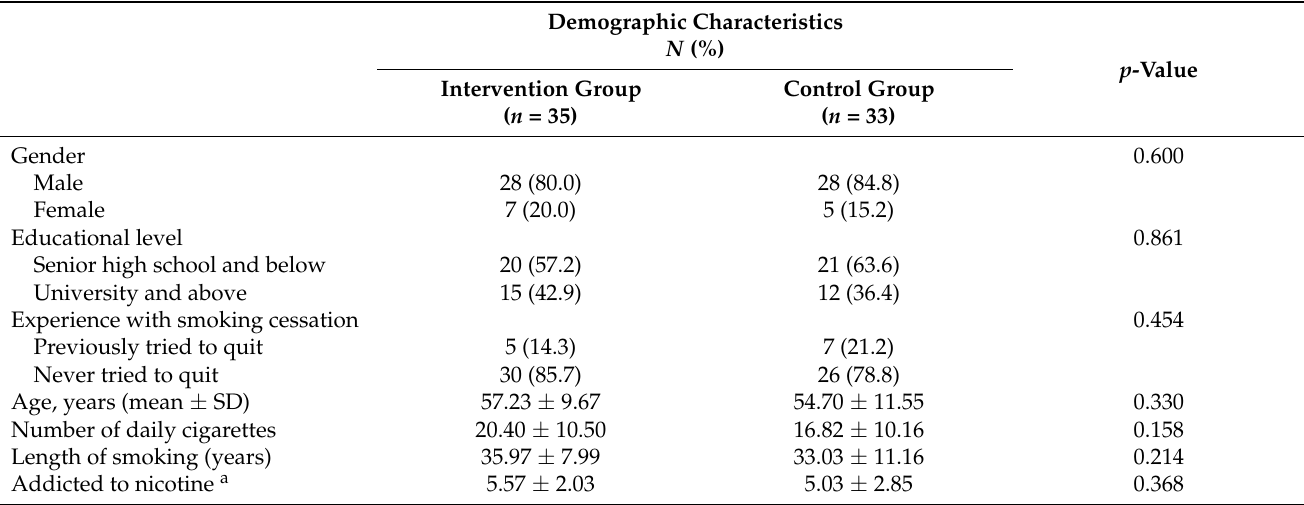
Table 1. Demographic characteristics and baseline values of the study groups. Demographic